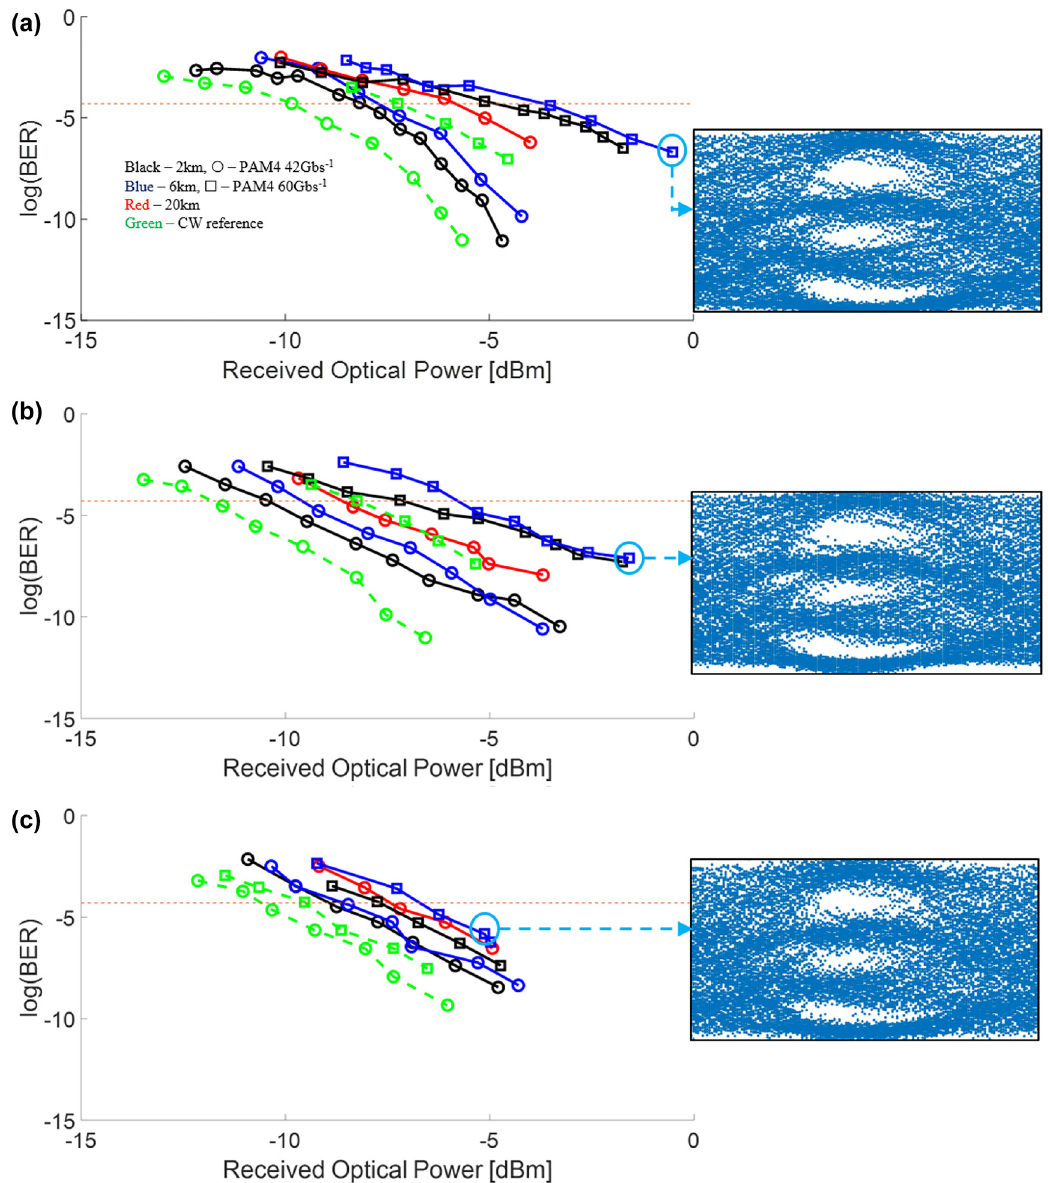
Figure 6: High-speed data experimental characterization using PAM4 data, showing BER less than the FEC threshold and open eye diagrams for all comb lines. 42 Gb s − 1 ( ○ ) and 60 Gb s − 1 ( □ ) PAM4 data are modulated onto the frequency combs lines prior to transmission through 2 km (black), 6 km (blue) and 20 km (red) optical fiber. Measured bit error rate for the comb lines at (a) 1542 nm, (b) 1564 nm and (c) 1575 nm. The CW reference is shown in green for both 42 Gb s − 1 and 60 Gb s − 1 PAM4 data. The orange dotted lines denote the FEC BER limit of 5 × 10 − 5 . BER below the FEC limit is achieved for all data rates tested and fiber lengths of 2 km and 6 km for all three comb lines. Eye diagrams for 60 Gb s − 1 PAM4 data after transmission through 6 km of optical fiber are shown for each comb